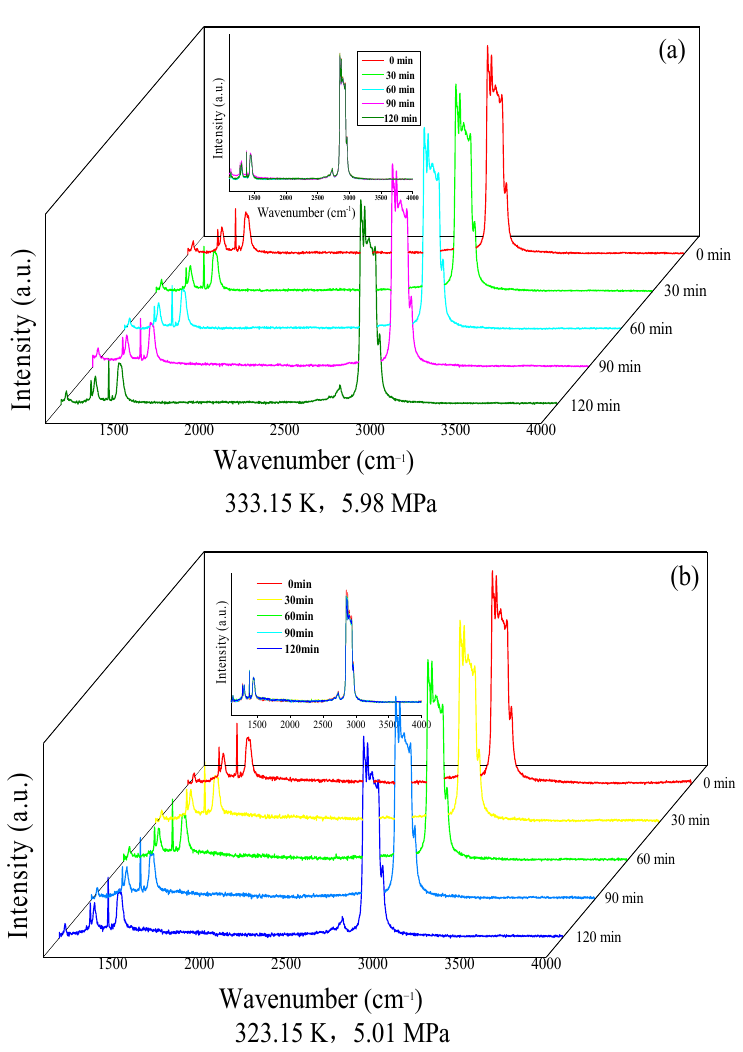
Figure 3. The Raman spectra of the CO 2 -saturated solution from 0 to 120 min after reaching the phase equilibrium, ( a ) CO 2 + n -decane, ( b ) CO 2 + n -decane + n